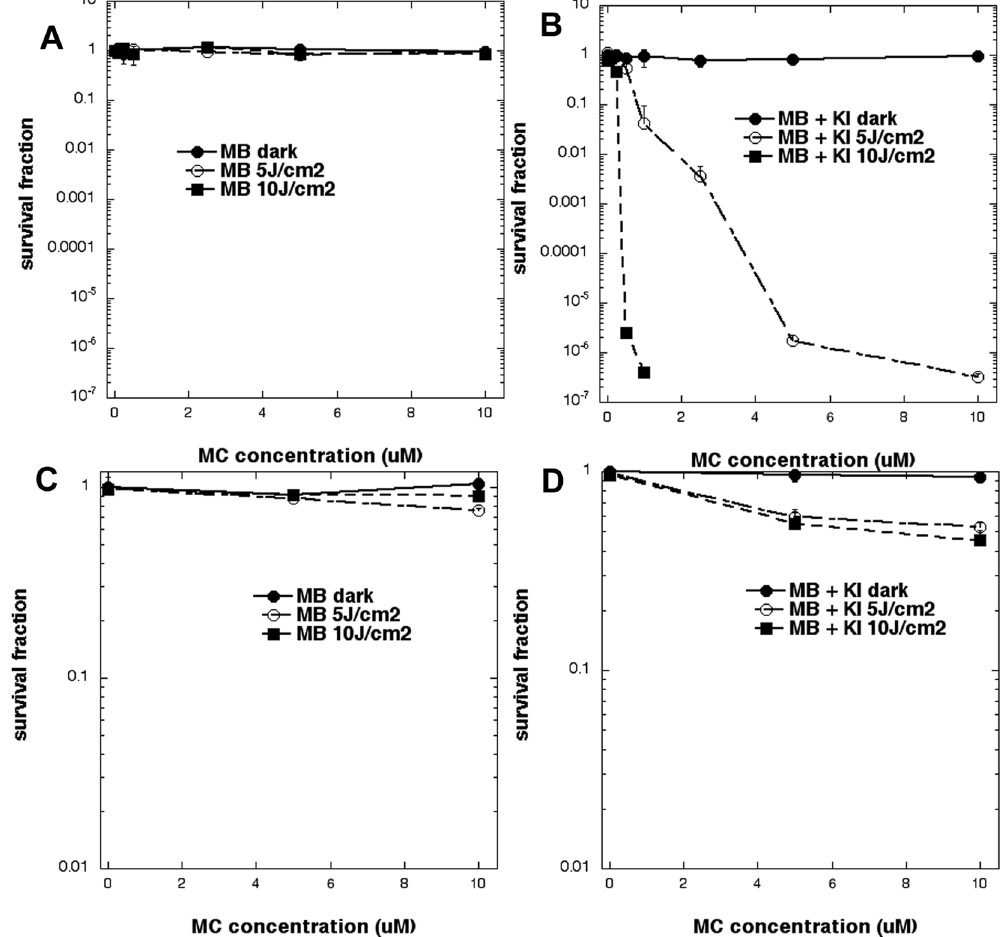
( C and D ) 100 mM KI solution and exposed to 5 or 10 J/cm 2 of 660 nm